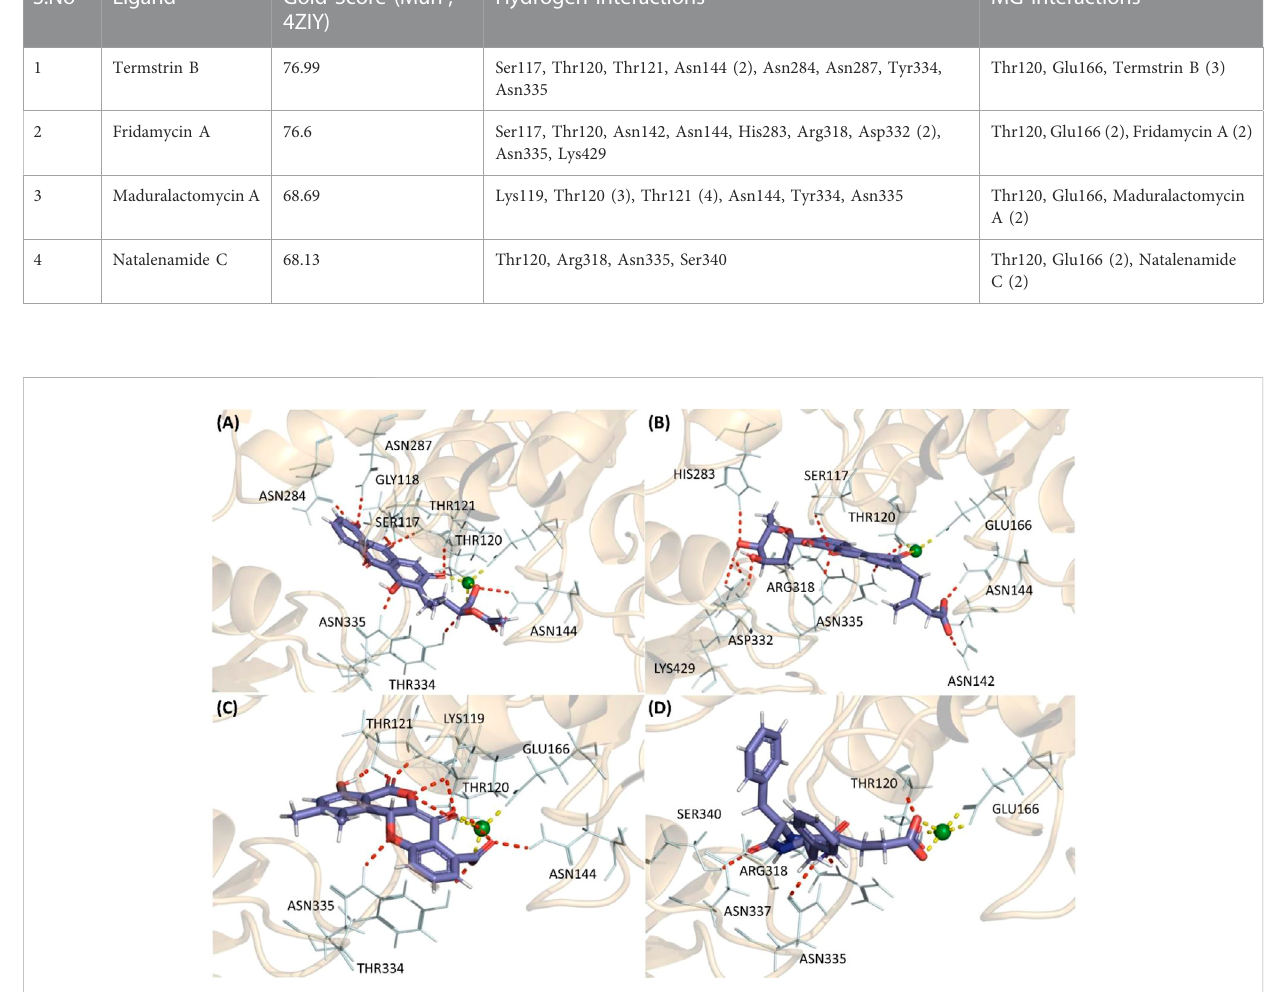
FIGURE 2 The highest scoring molecular docking poses of (A) Termstrin B (B) Fridamycin A (C) Maduralactomycin A, and (D) Natalenamide C bound to the active site of the MurF protein of A. baumannii. The hydrogen bonds between compounds and the protein residues/Mg ion are depicted as a red dotted line while hydrogen interactions among Mg ion and the protein residues are depicted via a yellow dotted line.